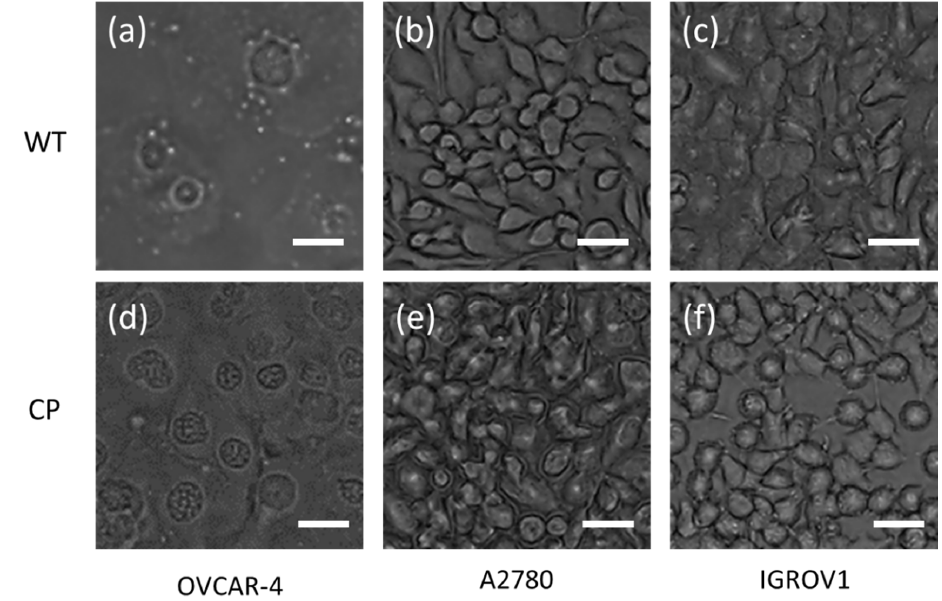
Figure 1. Cell images for serous cell type ( a ) OVCAR-4, ( b ) A2780, and ( c ) clear cell type IGROV1 of wild type (WT) ovarian adenocarcinoma cells and ( d–f ) which were cisplatin-resistant (CP). (Scale bar: 20 μ m)